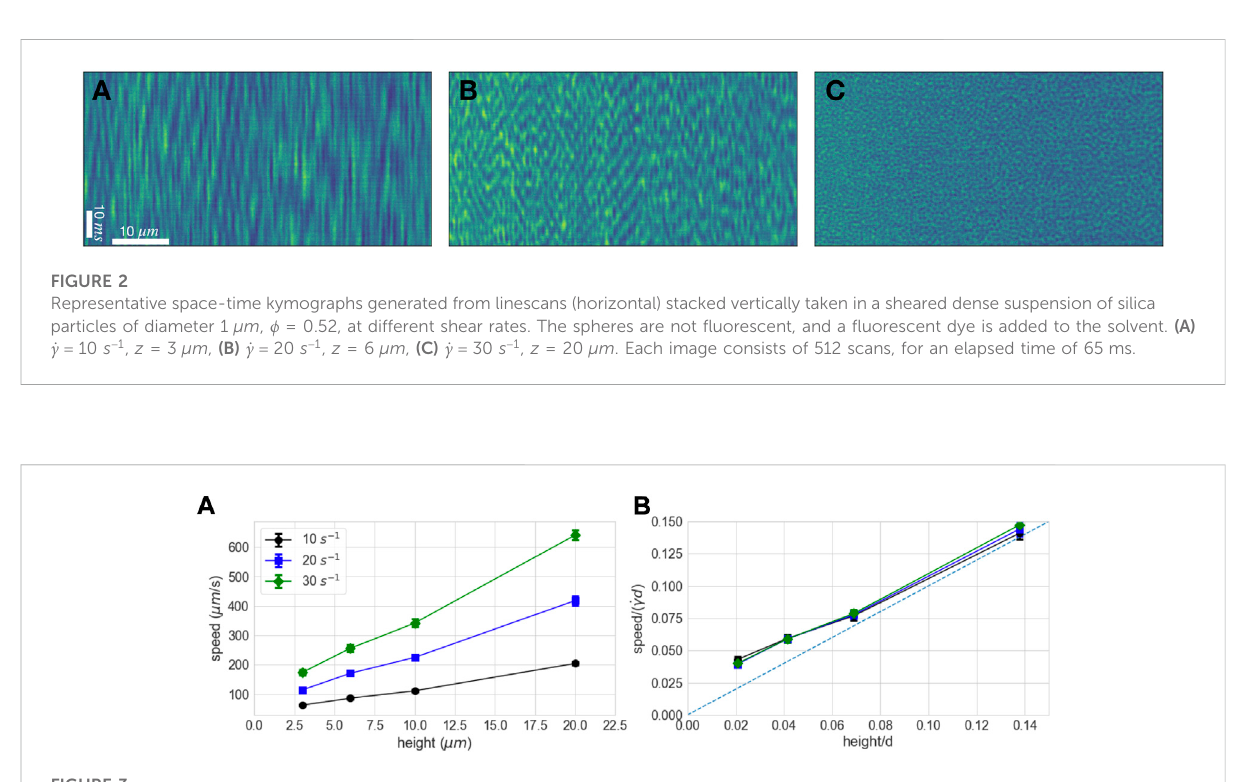
FIGURE 3 (A) Flowpro fi lesforconstantshearrategeneratedfromlinescandataatdifferentheights( ϕ =0.52),atdifferentconstantshearrates. (B) Particle speeds scaled by the speed of the top plate of the rheometer, _ γ d , as a function of height above the bottom surface, scaled by the rheometer gap. Error bars are standard deviations (N = 900). Dashed line corresponds to purely af fi ne fl ow with no wall